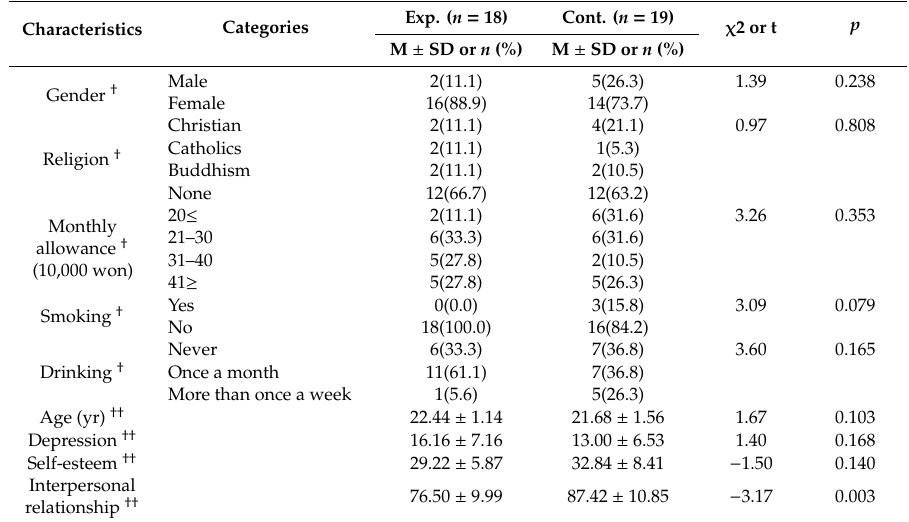
Table 2. Homogeneity of the general characteristics and dependent variables between the experimental and control groups ( N =